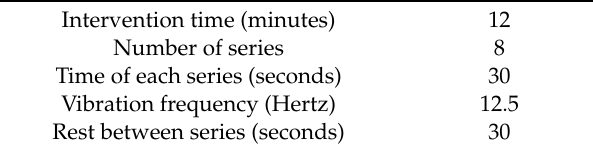
Table 1. Whole body vibration group training session